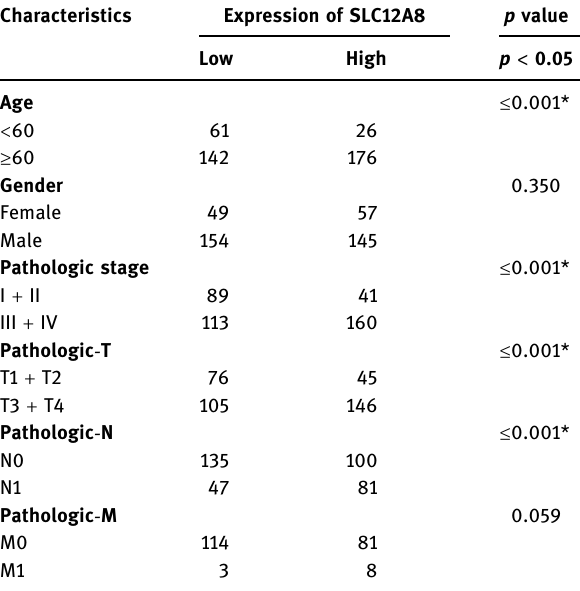
Table 1: Correlation between SLC12A8 expression and clinical features of bladder cancer